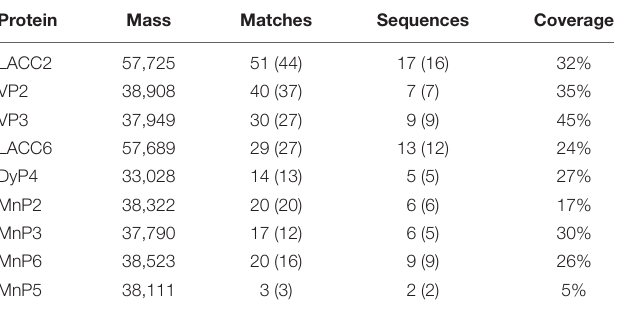
TABLE 1 | Secreted lignin-degrading enzyme proteins of wild type*. Protein Mass Matches Sequences